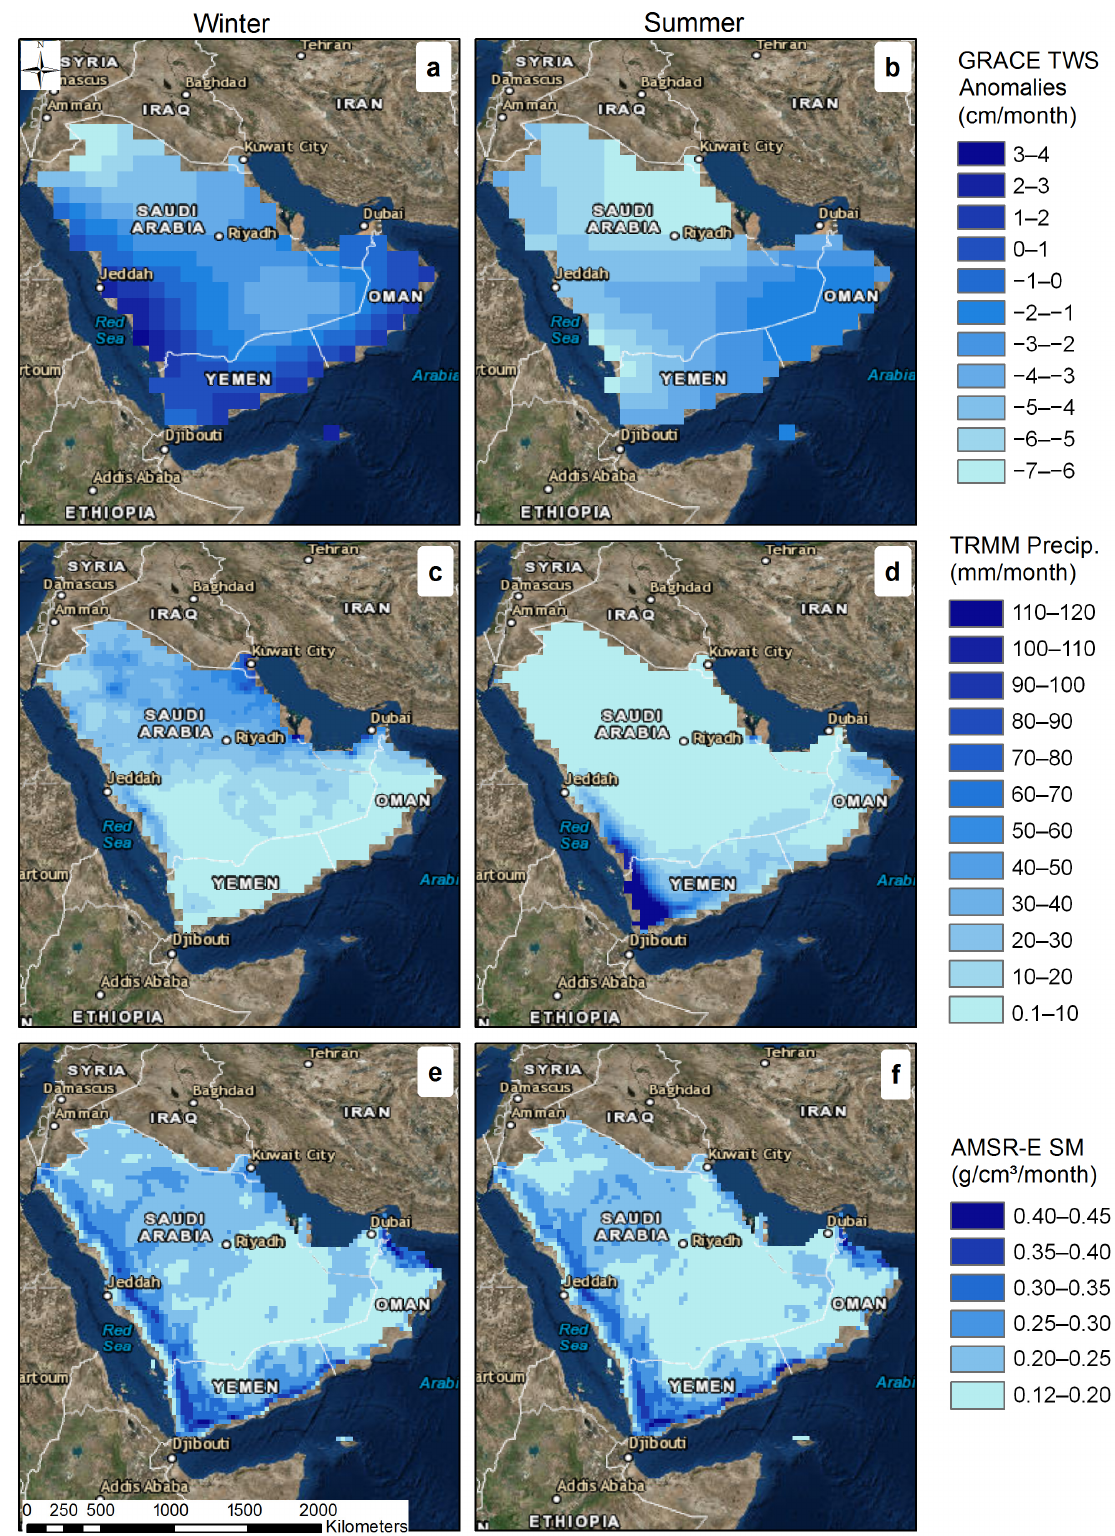
Figure 2. Spatial distribution of Gravity Recovery and Climate Experiment Total Water Storage (GRACE TWS) anomalies ( a , b ), Tropical Rainfall Measuring Mission (TRMM) precipitation ( c , d ), and Advanced Microwave Scanning Radiometer for Earth Observing System (AMSR-E) soil moisture ( e , f ) averaged from 2002 to 2011 for winter (December, January, February, and March—DJFM) and summer (June, July, August, and September—JJAS)